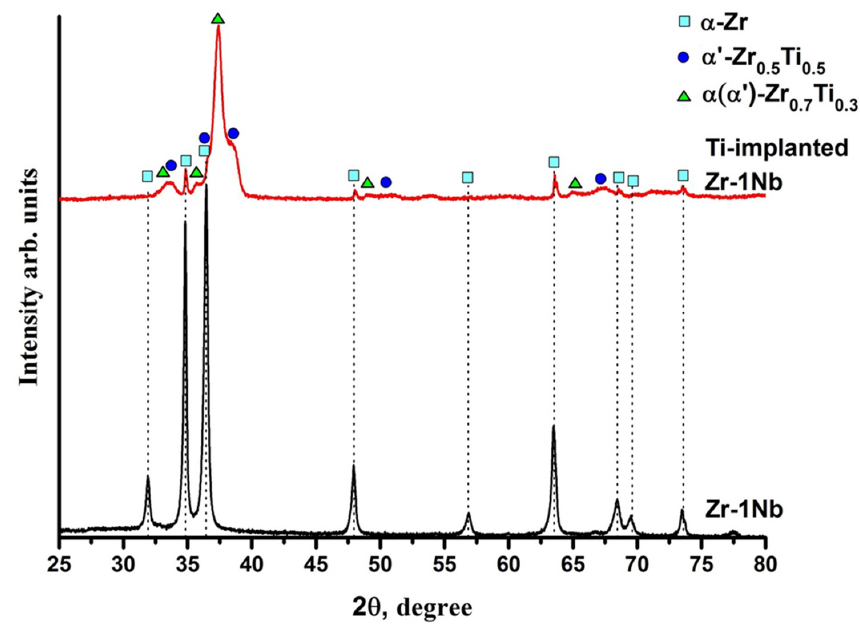
Figure 2. X-ray diffraction (XRD) patterns of ( a ) as-received and ( b ) Ti-implanted Zr-1Nb alloy.